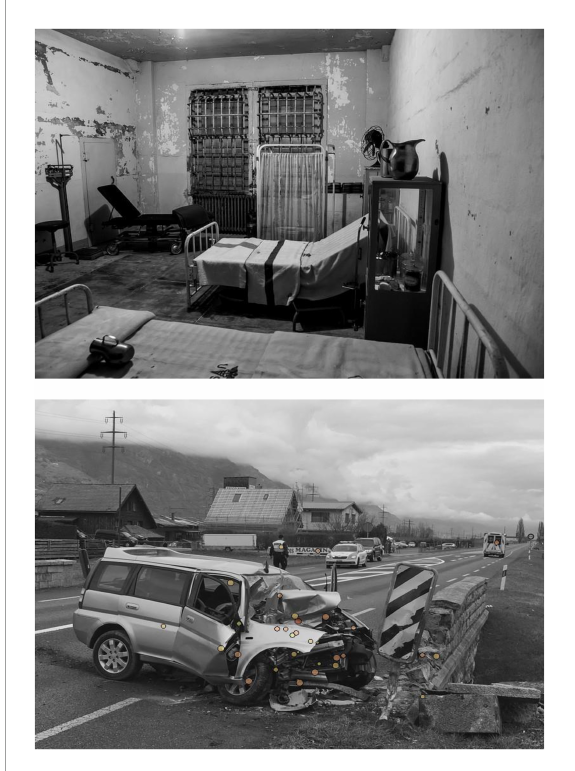
FIGURE2 Upper panel: Example of a picture judged by participants to contain diffuse emotion. No specific area is highlighted, showing that participants considered the emotion to be spread through diverse, not precise, elements. Lower panel: Example of a picture judged by participants to be focal emotion. The source of the emotion is revealed by the sum of the points attributed on each image by participants. Different colors of the marks correspond to various levels of valence, from − 4 (red) to 4 (green). No one rated this picture as positive, and so the color ranges from − 4 (red) to − 2 (yellow). Mark size revealed the arousal level, from 1 (the smallest points) to 8 (the largest